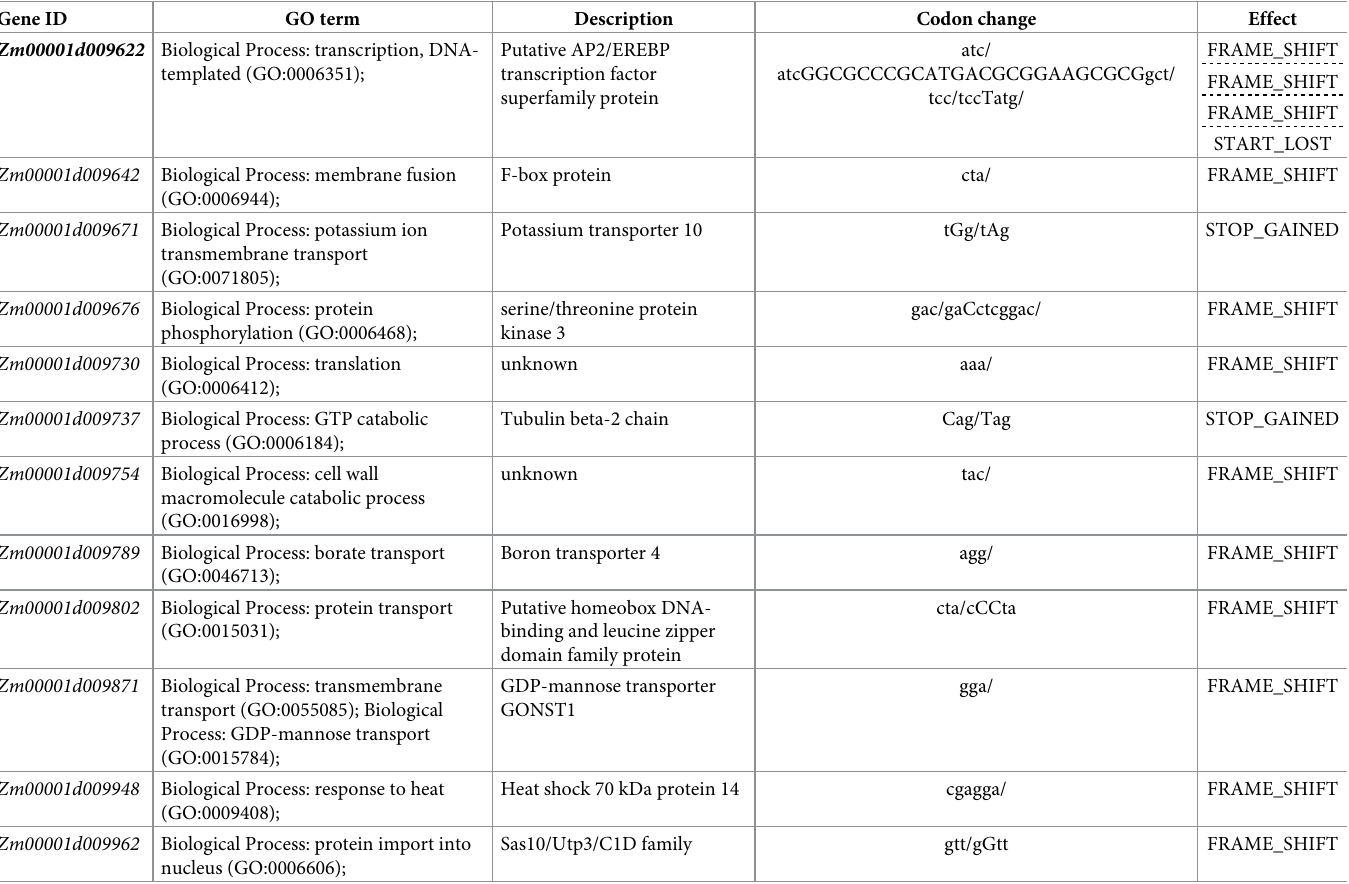
Table 5. Selected candidate genes of leaf angle in qLA08-01 with mutations in the CDS region. Gene ID GO term Description Codon